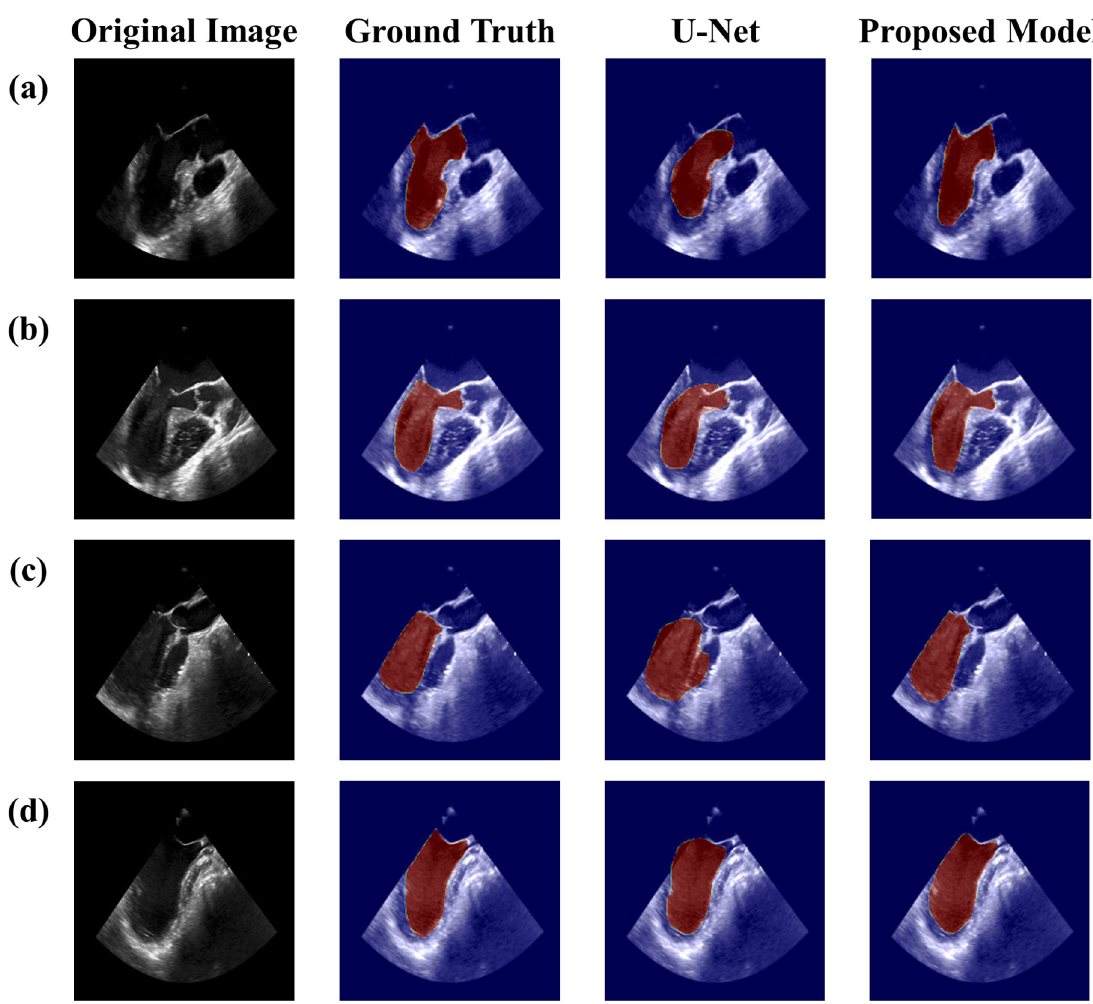
Fig 3. Comparison of the LV segmentation results between U-Net and the proposed model. LV, left